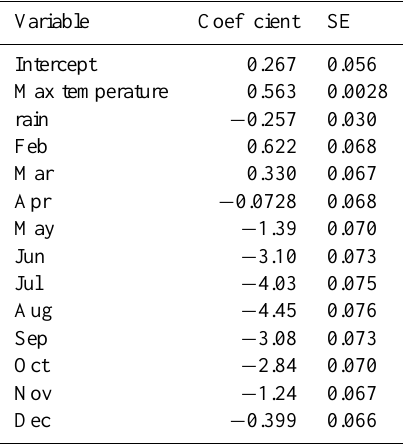
Table 5. Regression model for daily temperature range ( ◦ C). Variable Coefficient